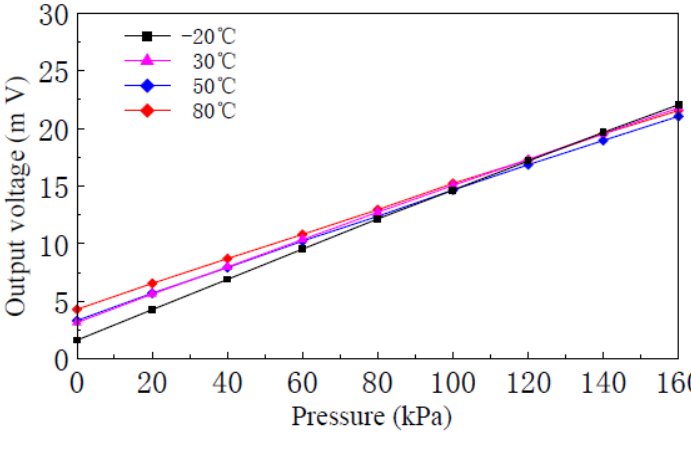
Figure 12. Input-output characteristics curves of the nc-Si/c-Si heterojunction MOSFETs pressure sensor at different